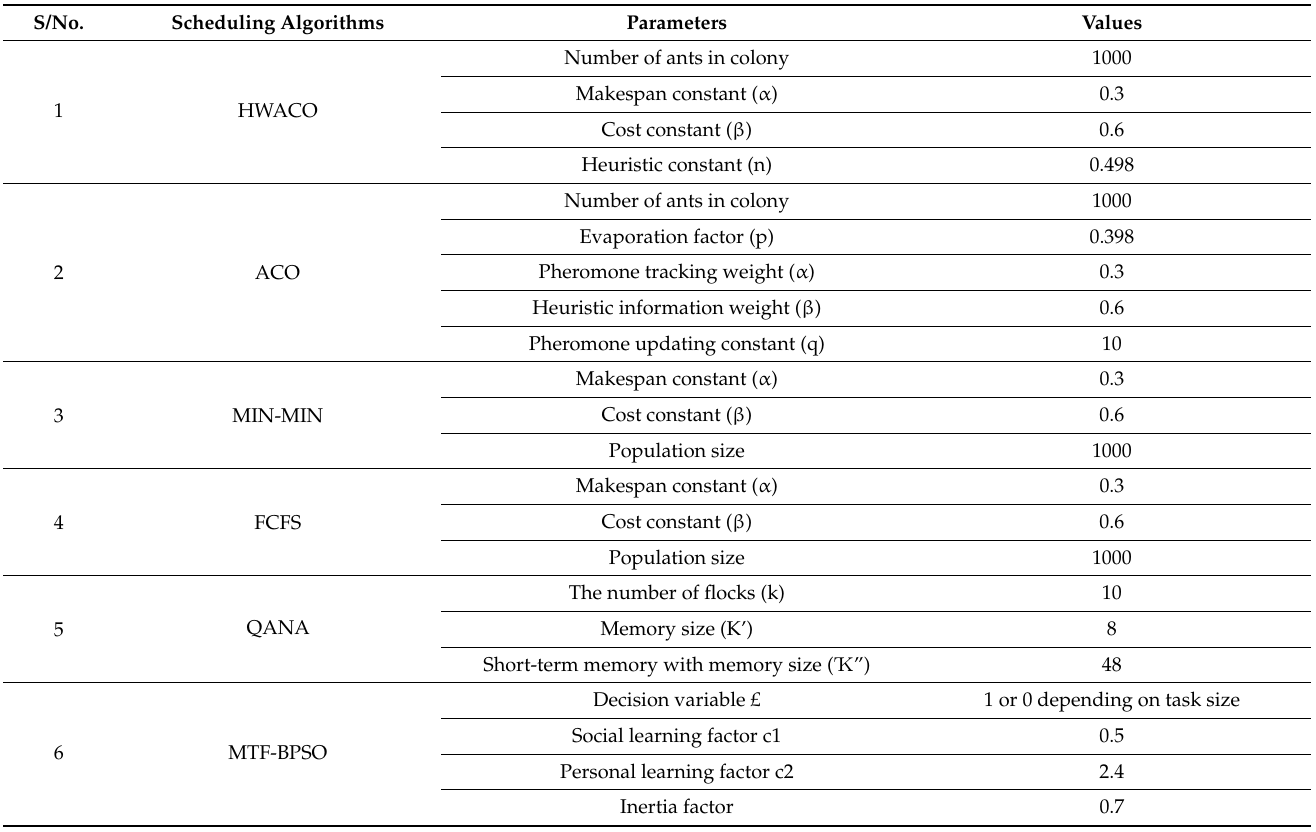
Table 3. Parameter